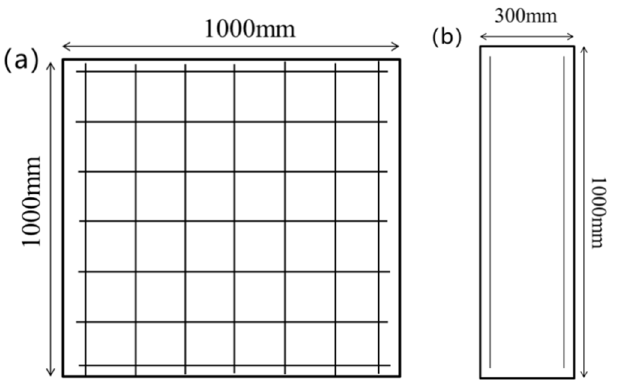
Figure 1. Reinforcement diagram of reinforced concrete slabs: ( a ) front face; ( b ) side